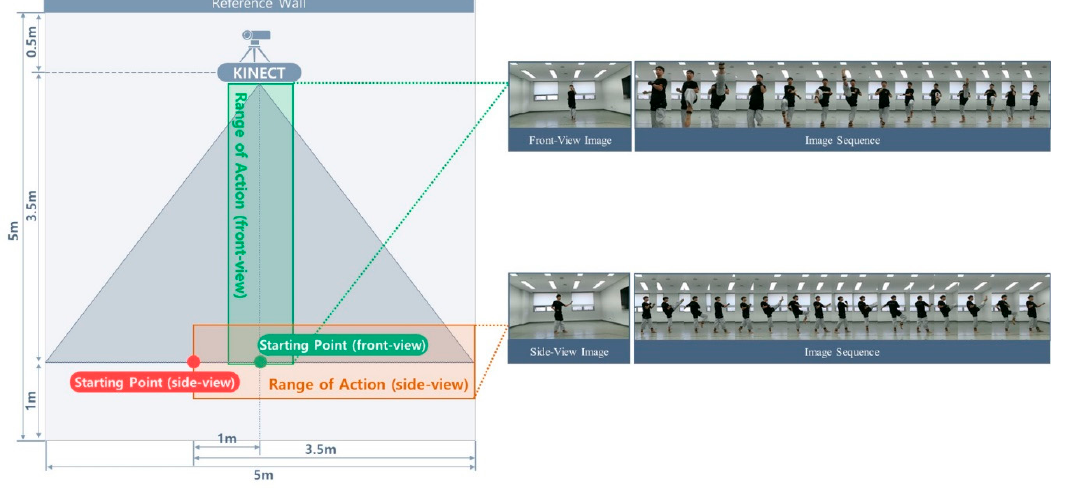
Figure 2. Capture space and setup for front and side view images.